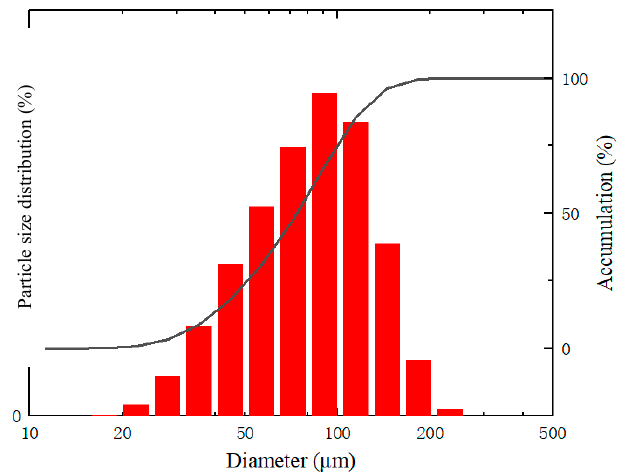
Figure 1. Particle size distribution of Mg.